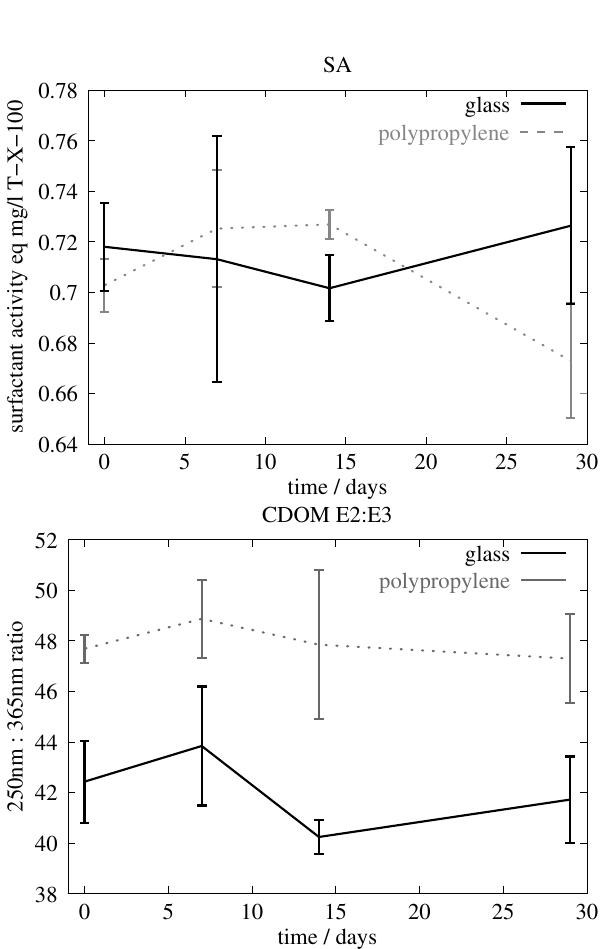
Fig. 1. Surfactant activity (SA) and CDOM E 2 : E 3 vs. storage time for estuarine SML samples stores in glass and plastic, SA (top) exemplary for the situation without change, and CDOM E 2 : E 3 (bottom) as the only example where there is an influence.